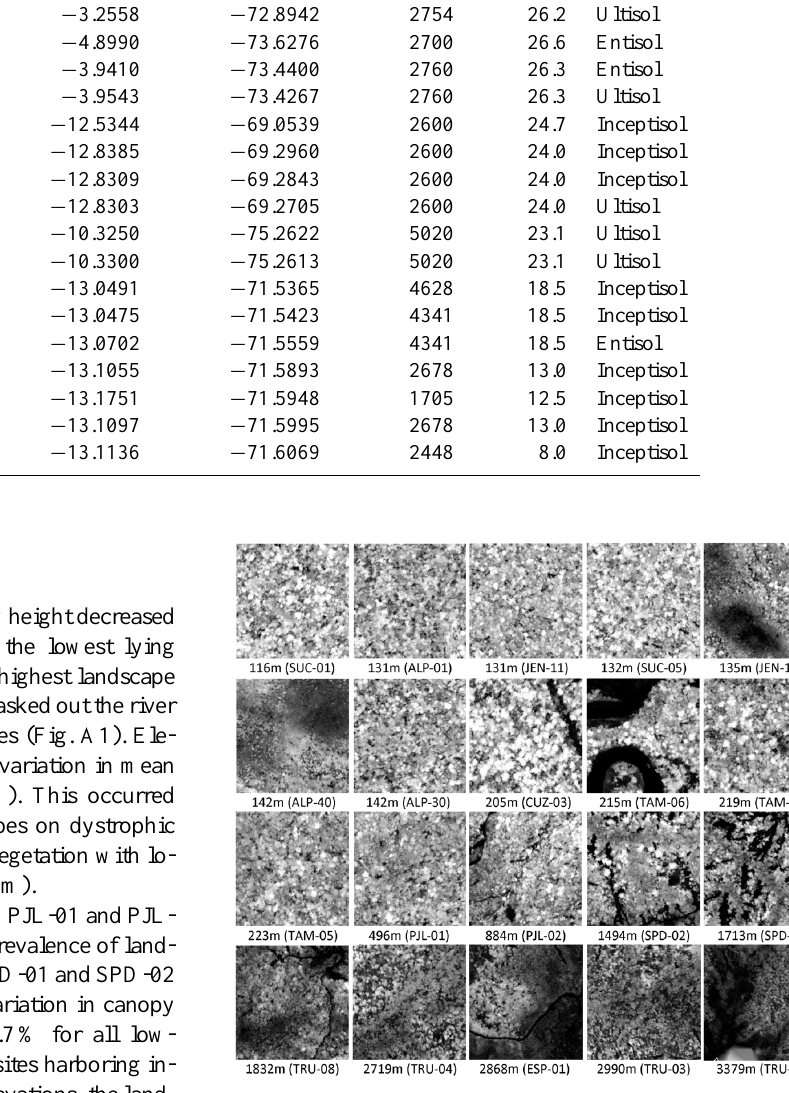
Fig. 2. Vegetation canopy height after removing variation in terrain (see Fig. 1) at 1.1m spatial resolution throughout forests along the elevation gradient. Site names are shown in parentheses, matching those listed in Table